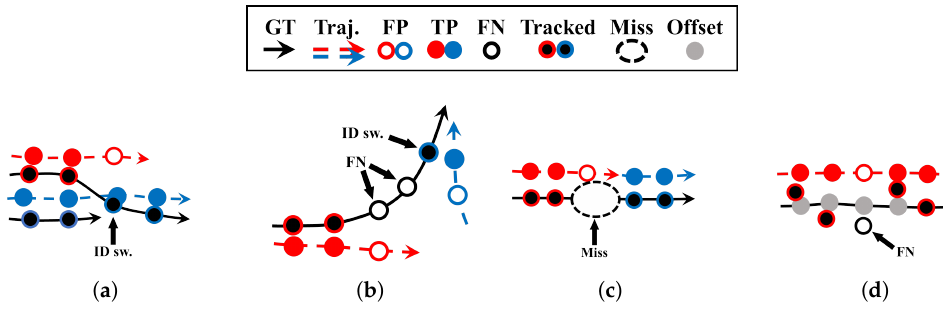
Figure 2. Four cases illustrating tracker-to-target assignments. ( a ) False positive and ID switch occur when vehicles change lanes. ( b ) False positive, false negative and ID switch occur when the vehicle turns. ( c ) Data loss occurs when the road sensor loses the vehicle signal. ( d ) Road sensors acquire vehicle signals with offset